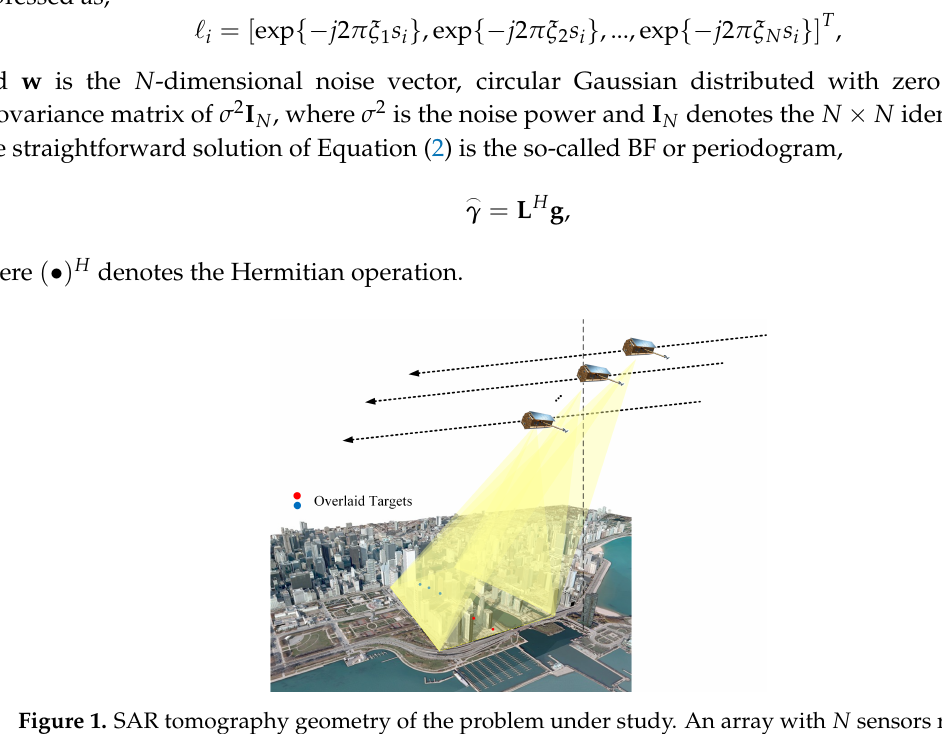
Figure 1. SAR tomography geometry of the problem under study. An array with N sensors receives signal from two or more scatterers (overlaid targets are denoted by red and blue dots). Note that distances are not in